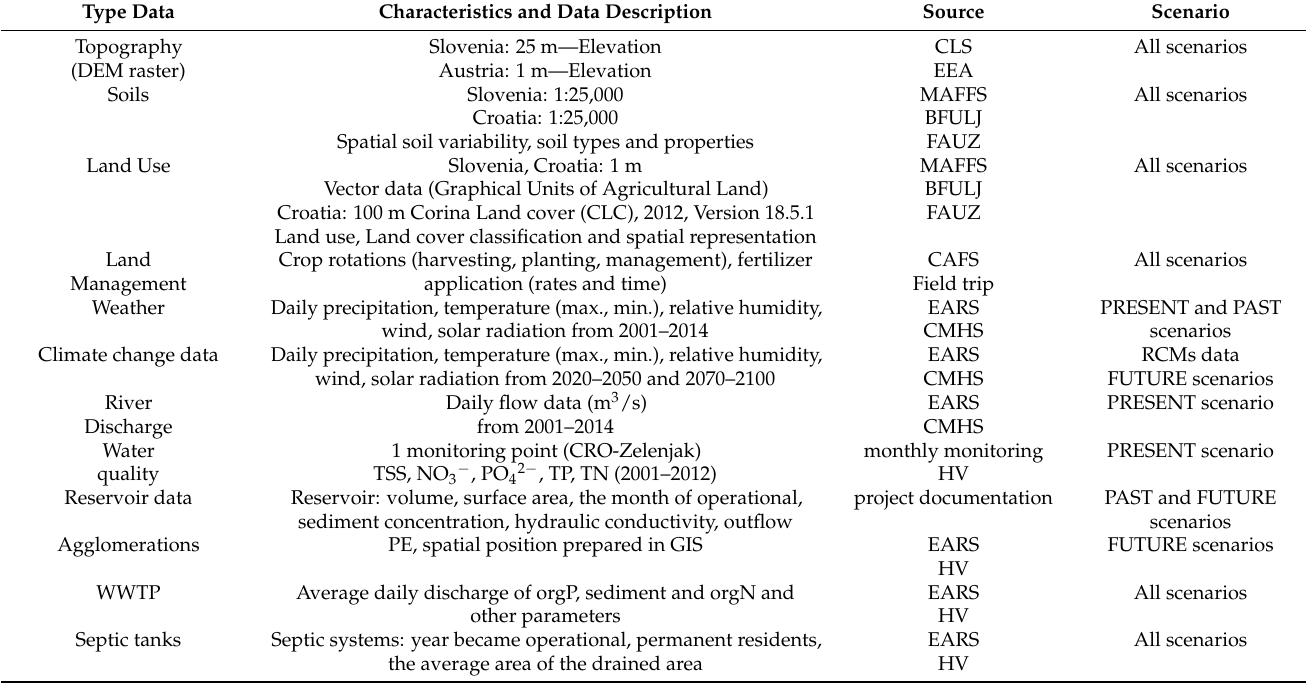
Table 1. SWAT model input data sources for the Sutla river